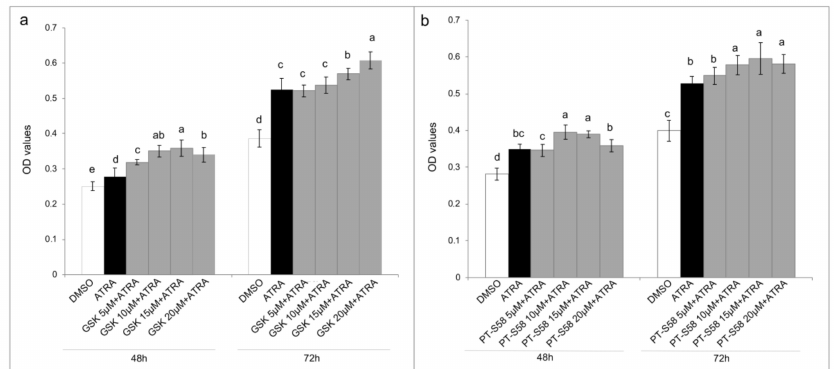
Figure 4. PPAR β / δ inhibition. MTT assays express as optical density (OD) values in T24 cells treated with DMSO, ATRA 10 µ M, or ATRA 10 µ M added with four GSK0660 (GSK, panel ( a )) or PTS-58 (panel ( b )) concentrations (5 µ M, 10 µ M, 15 µ M, and 20 µ M), selective and full PPAR β / δ antagonists, respectively, for 3 days (showed 48 h and 72 h results). Means ± SD ( n = 12). Means with di ff erent letters are significantly di ff erent ( p < 0.05) within each treatment lapse.